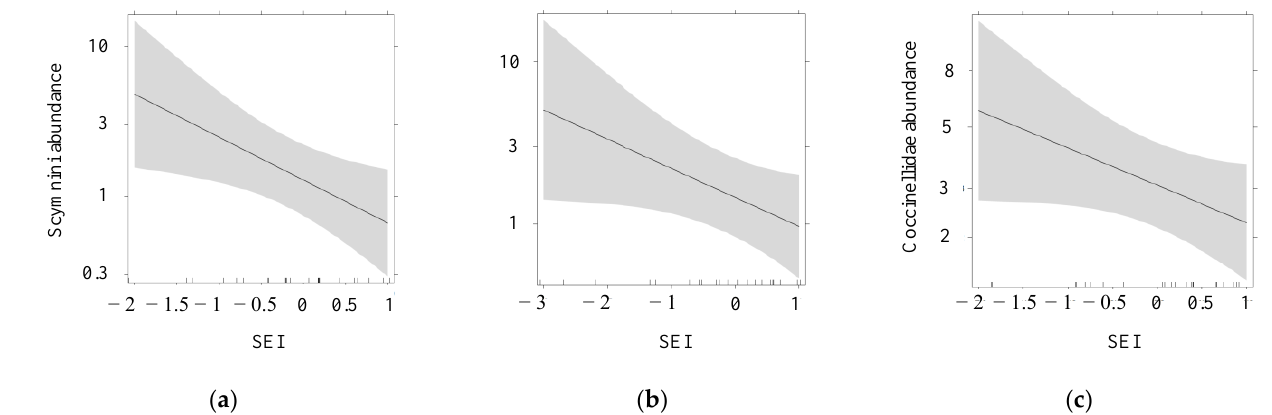
Figure 4. Response of the Scymnini and Coccinellidae abundance to landscape diversity (SEI) (standardized) surrounding vineyards at different buffers: ( a ) Scymnini — 500 m; ( b ) Scymnini — 1000 m; ( c ) Coccinellidae — 1500 m. The presence of artificial territory and vineyards increased Scymnini abundance at 750 m but not at the other buffers. Coccinellidae abundance was also positively influenced by the complexity of the landscape configuration (MPFD) at larger buffers (2000 m and 1500 m) (Figure 5), and vineyards showed a positive influence on Scymnini abundance at 2000 m, 1500 m, and 750 m (Table S2).